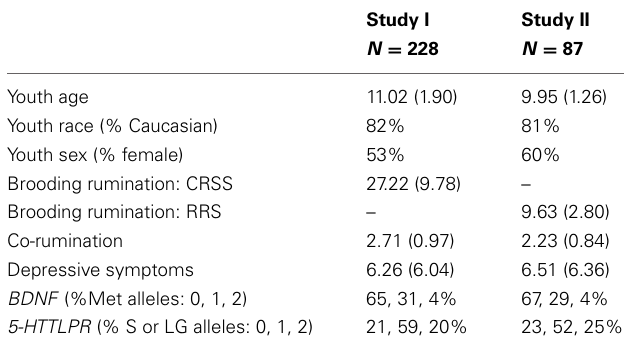
Table 1 | Descriptive statistics of participants from primary study (I) and replication study (II).